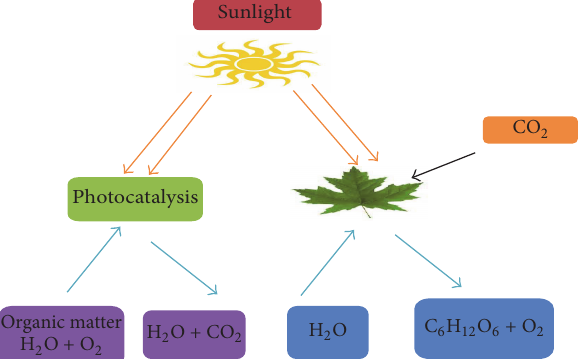
Figure 1: Comparison between the actions of a catalyst and chlorophyll.